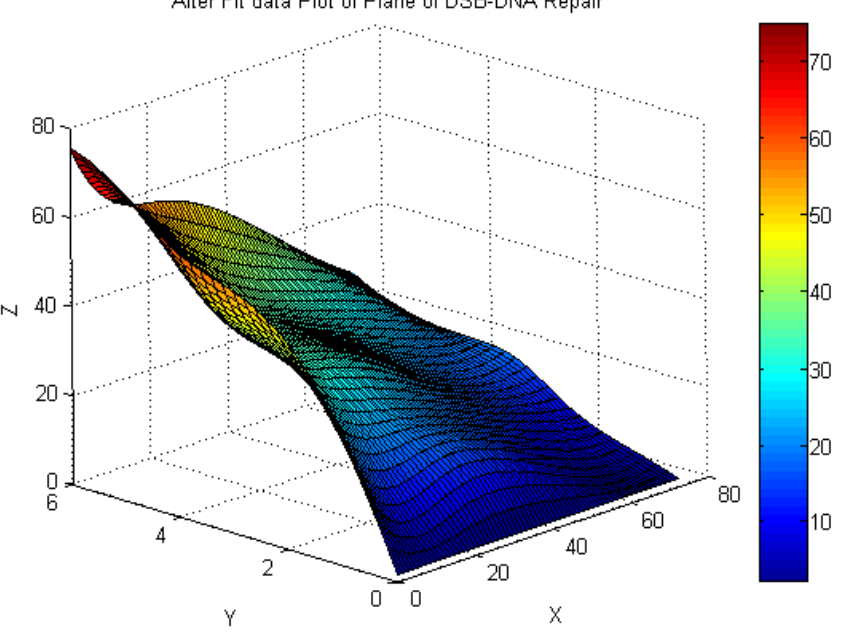
Figure 8. The three-dimensional plane model obtained by combining the dose- and time-response relationship of OTM derived from the comet assay within 72 h after irradiation [ Y axis: radiation dose (Gy); X axis: time after irradiation (h); Z axis: value of